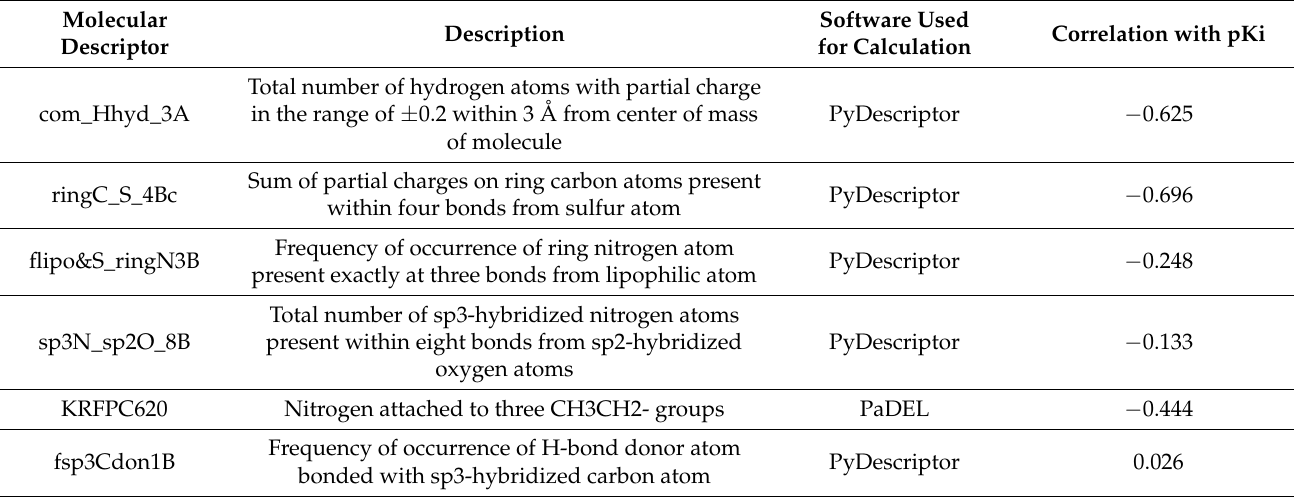
Table 1. Some details of constituent molecular descriptors present in